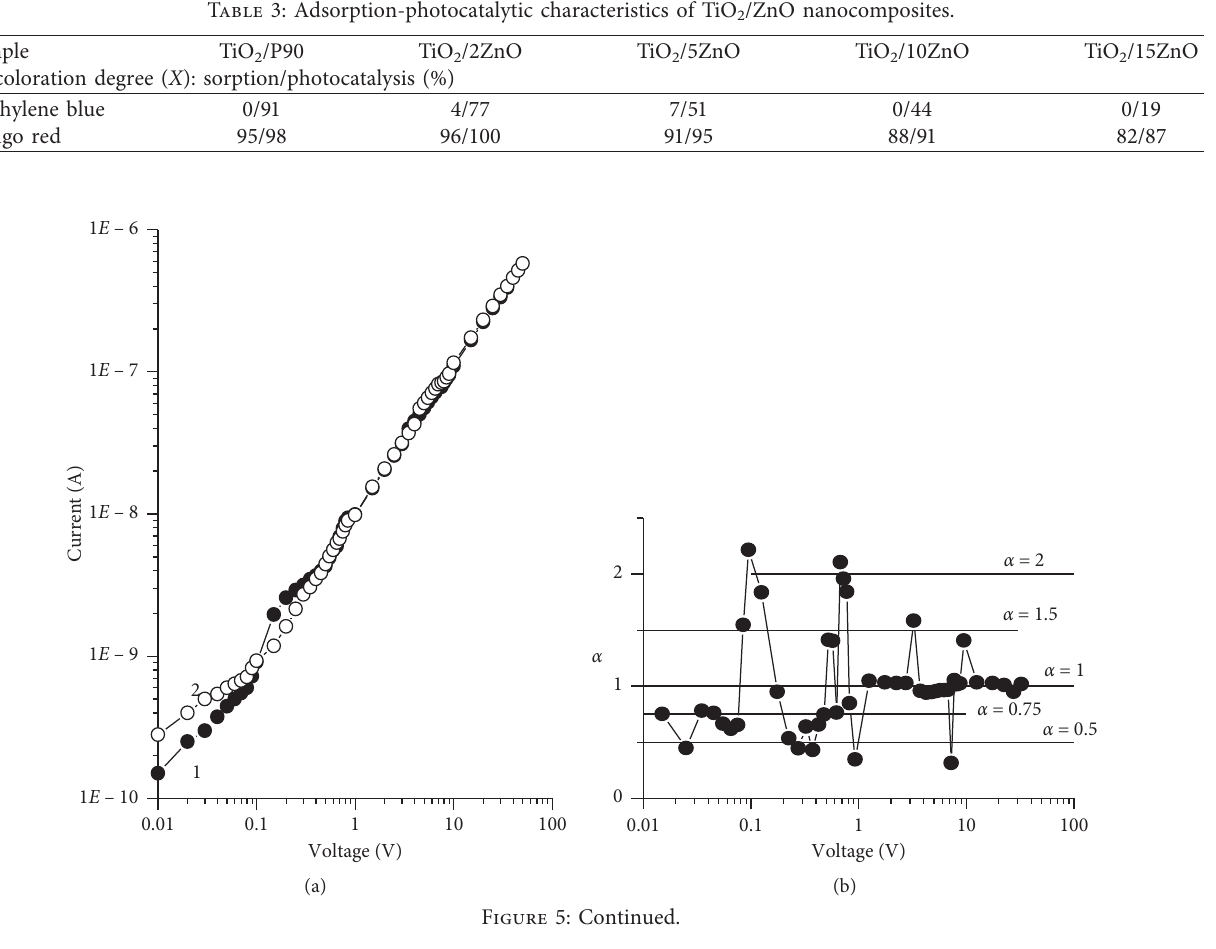
Table 3: Adsorption-photocatalytic characteristics of TiO